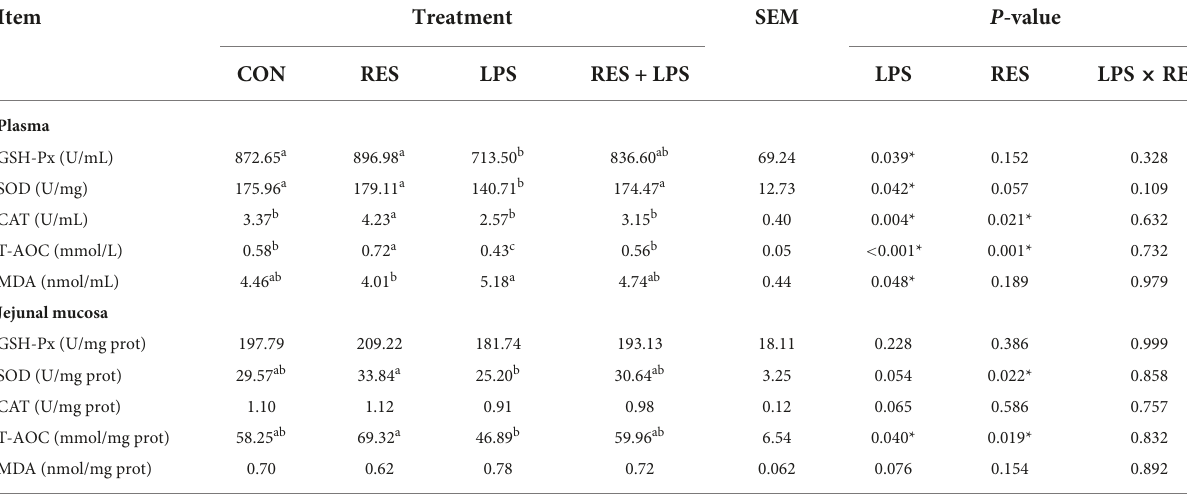
TABLE 5 Effect of dietary resveratrol supplementation on antioxidant capacity in yellow-feathered broilers with lipopolysaccharide 1 . Item Treatment